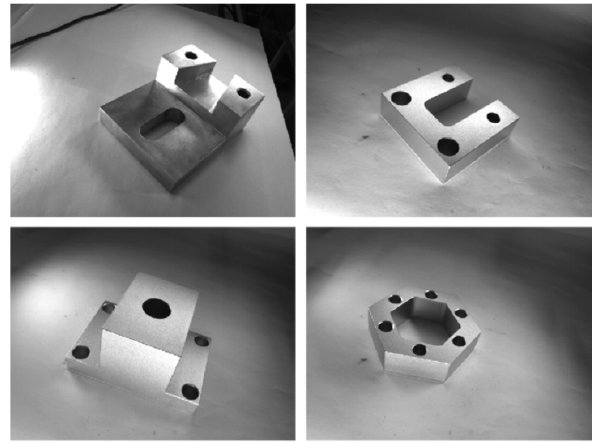
Figure 4. Symmetrical objects.